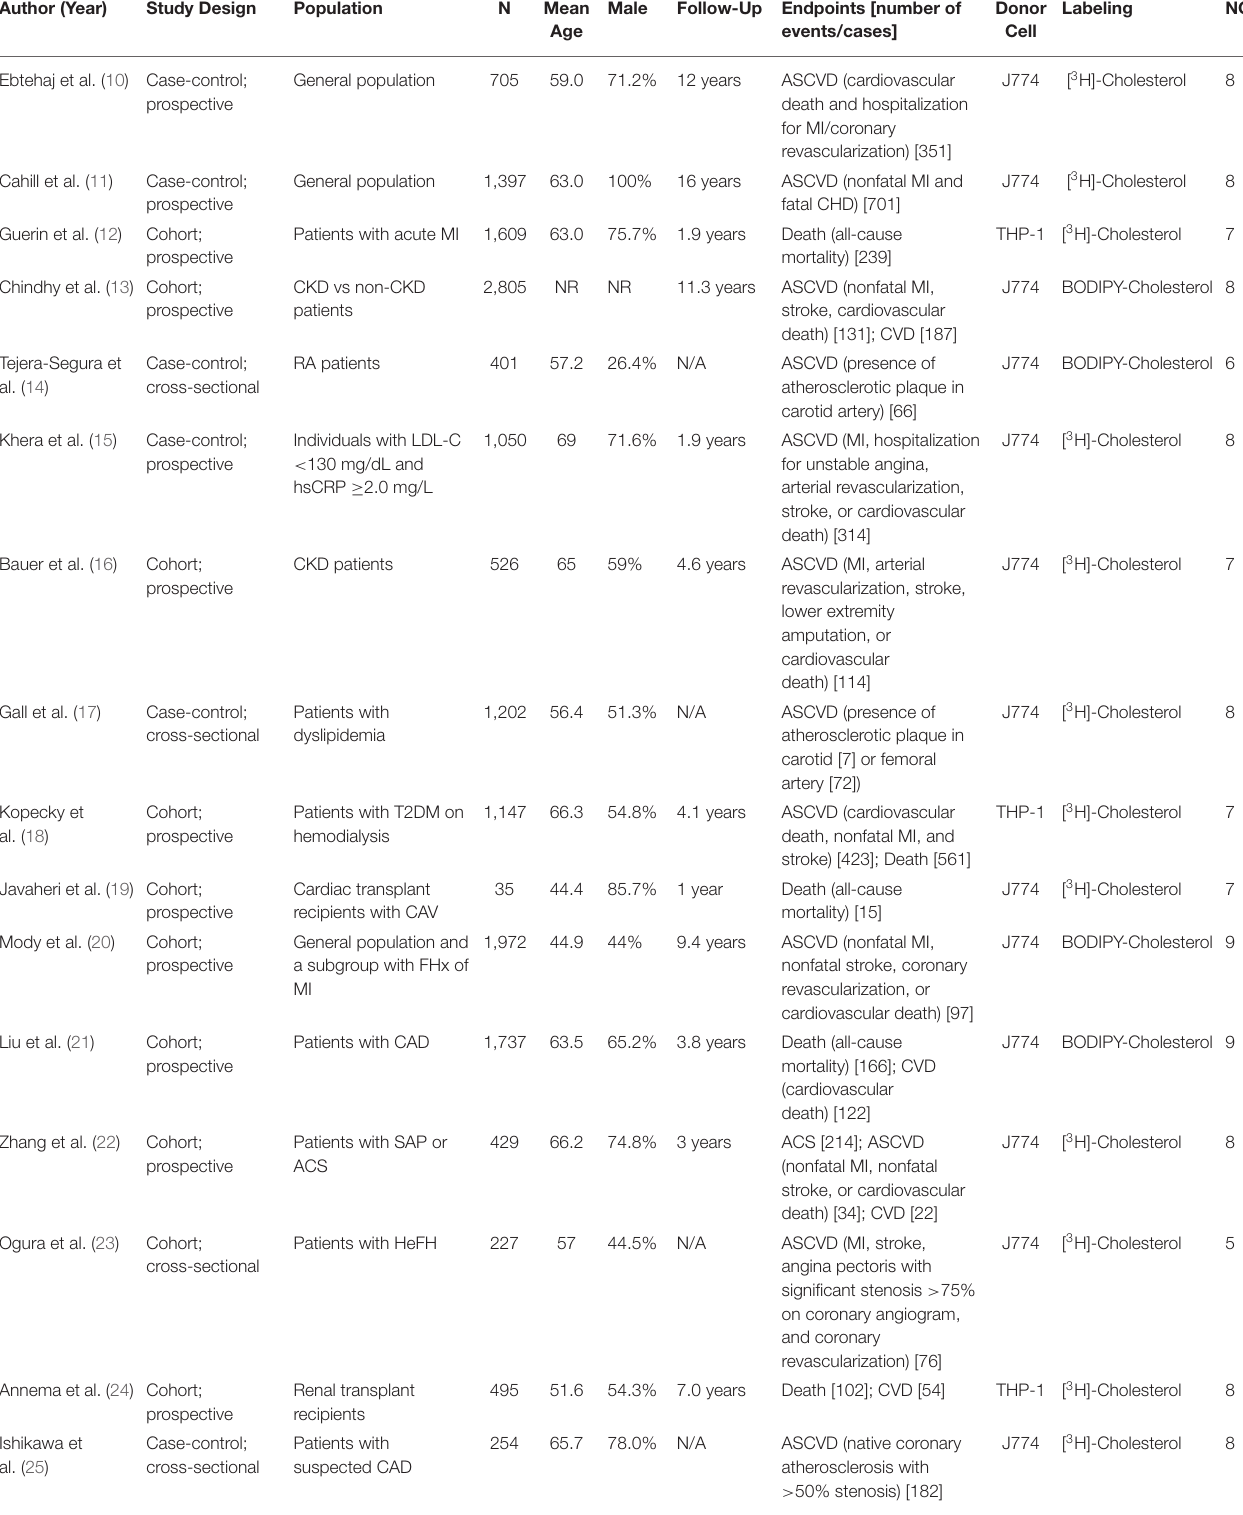
TABLE 1 | Summary of included